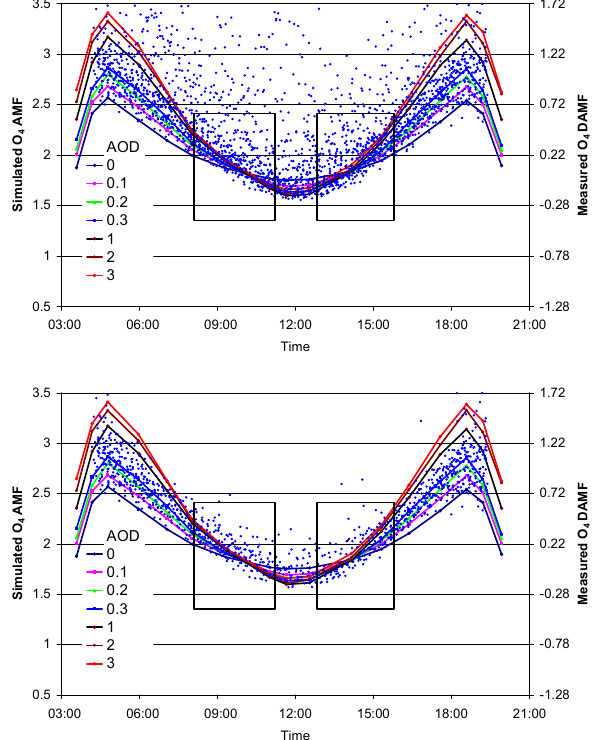
Figure 6. Comparison of measured O 4 DAMFs (right axis) with simulated O 4 AMFs (left axis) for different AOD. In the top panel all observations are shown and in the bottom panel only clear-sky observations are shown. The rectangles indicate the SZA ranges (30–50 ◦ ) used for the calibration of the O 4 measurements. The right y axis is shifted compared to the left y axis by the O 4 AMF of the FRS ( − 1 . 78). The measurements are from the period 12 June to 15 July 2009; the simulations are performed for a day (26 June 2009) in the middle of the campaign (aerosol layer height: 1000m, surface albedo: